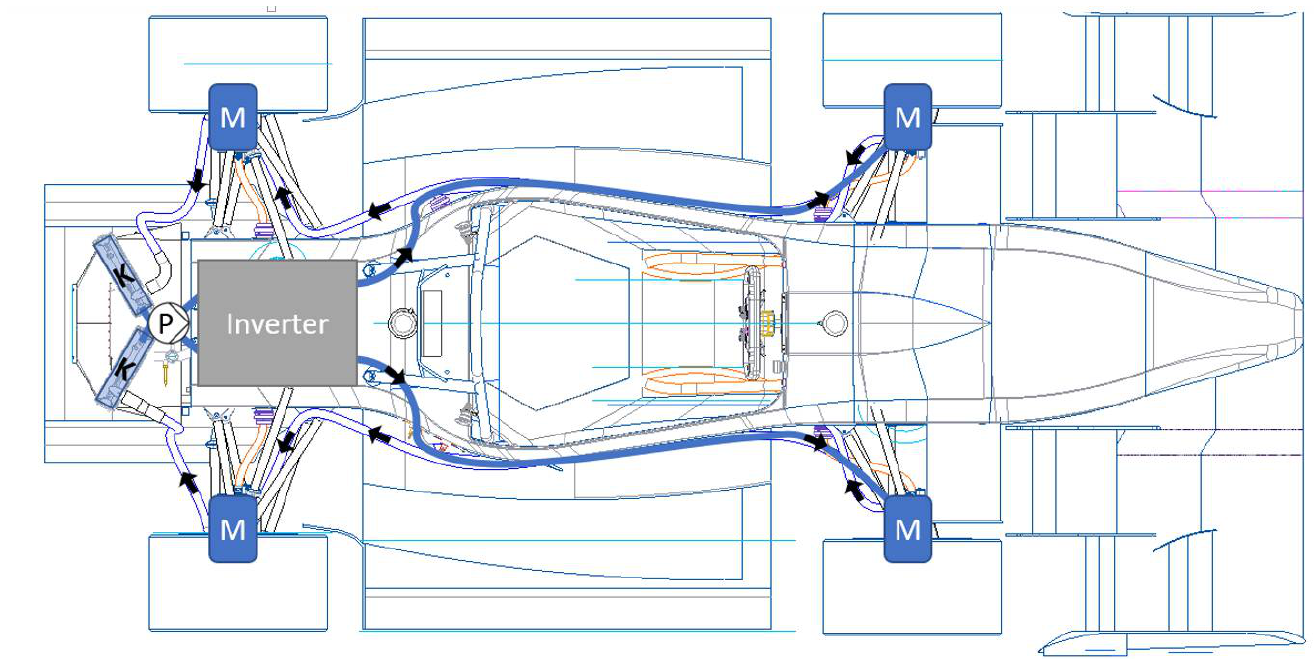
Figure 3. Concept sketch of the water-cooling system for the electric race car.